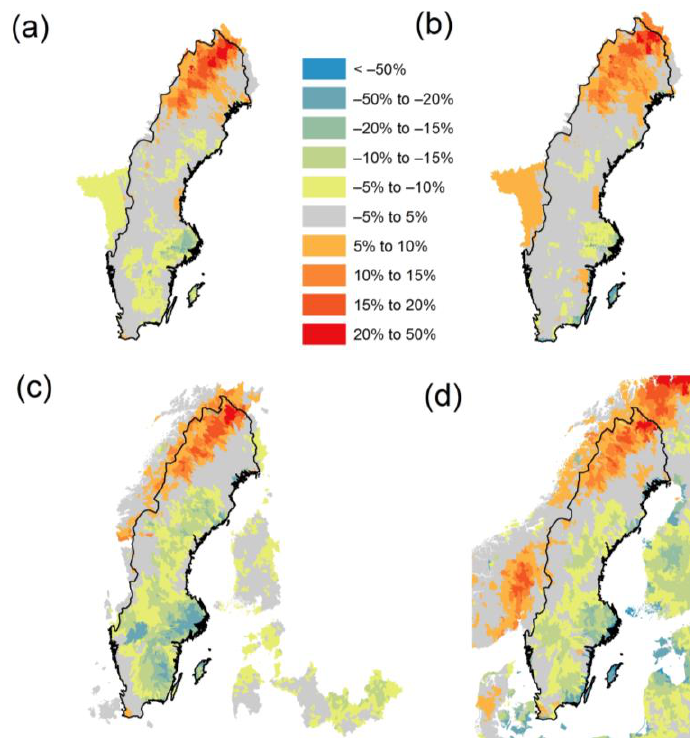
Figure 4. Percentage change in local runoff for the period 2071–2100 as compared to 1981–2010 in a climate projection run through ( a ) S-HYPE using Swedish data; ( b ) S-HYPE using European data; ( c ) E-HYPE using Swedish forcing data; and ( d ) E-HYPE using European forcing data. Swedish data are defined as the scenario bias-adjusted to PTHBV and European data are defined as the scenario bias-adjusted to the E-HYPE forcing data.